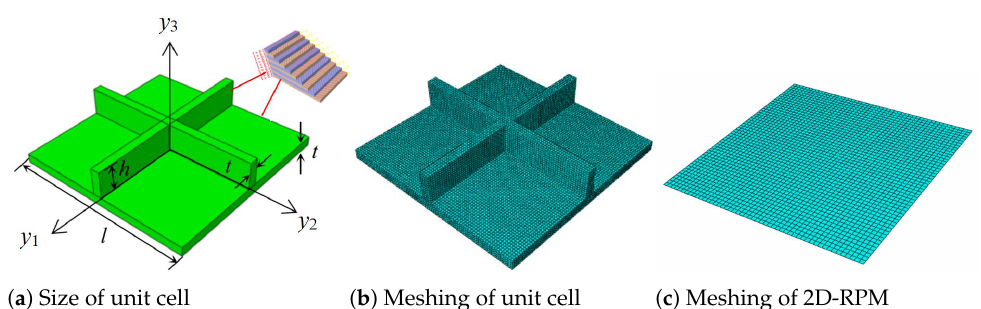
Figure 4. Meshing of unit cell and 2D reduced-order plate model (2D-RPM) of OSFP.